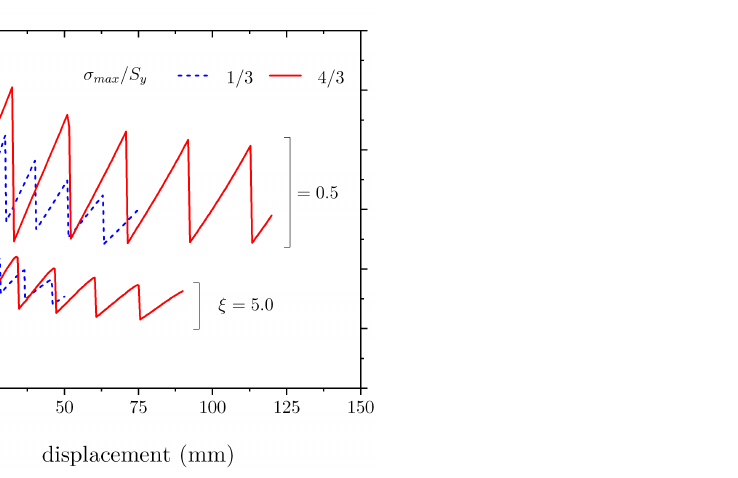
Figure 8. Effect of cohesive properties on the load–displacement response of a notched DCB adhe- sive joint.